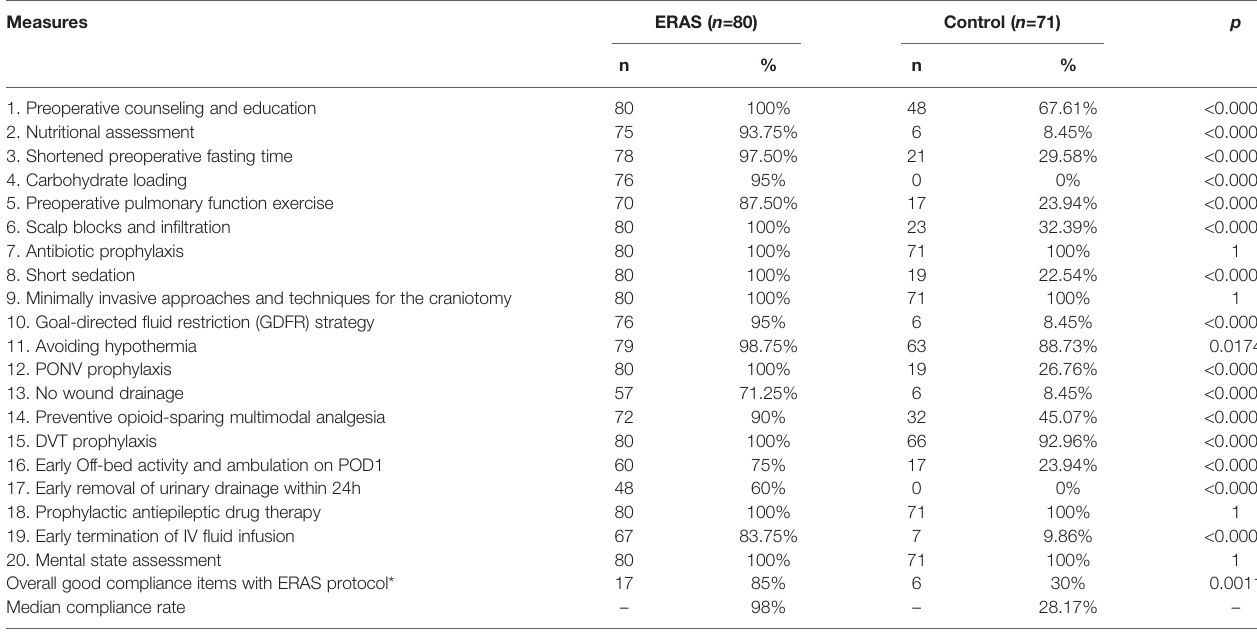
TABLE 3 | Key measures on ERAS protocol for gliomas and patient compliance. Measures